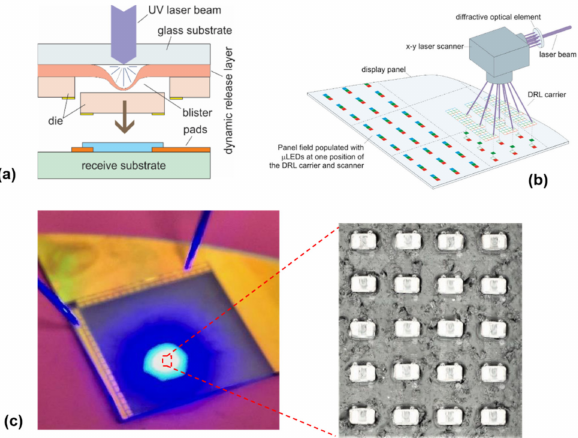
Figure 18. ( a ) Working principle of the laser-induced forward transfer (LIFT), ( b ) a schematic illustrating the LIFT based on using a multiple beam scanning strategy. ( c ) transferred and bonded 55 × 32 × 6 µ m µ LEDs on a test substrate by LIFT. Adapted with permissions from [229]. Copyright John Wiley and Sons,